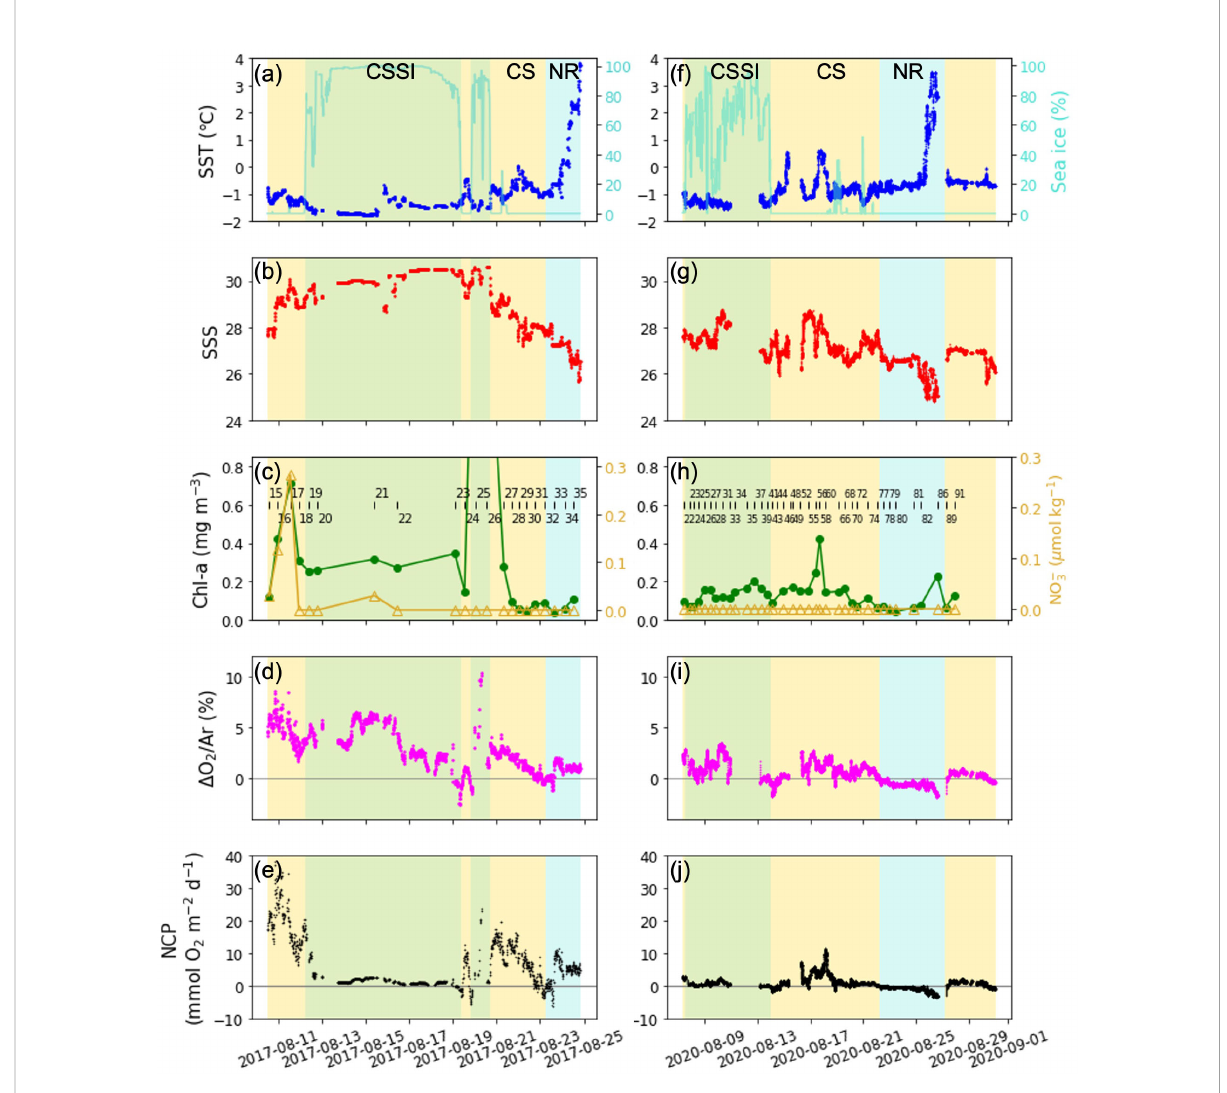
FIGURE 2 Time series of SST, sea ice (%), SSS, Chl- a , nitrate (NO 3- ), D O 2 /Ar, and NCP in (A – E) 2017 and (F – J) 2020; green, yellow, and blue shades denote the CSSI, CS, and NR, respectively. Chl- a and nitrate concentrations over the mixed layer for each station; (C, H) the station number is denoted